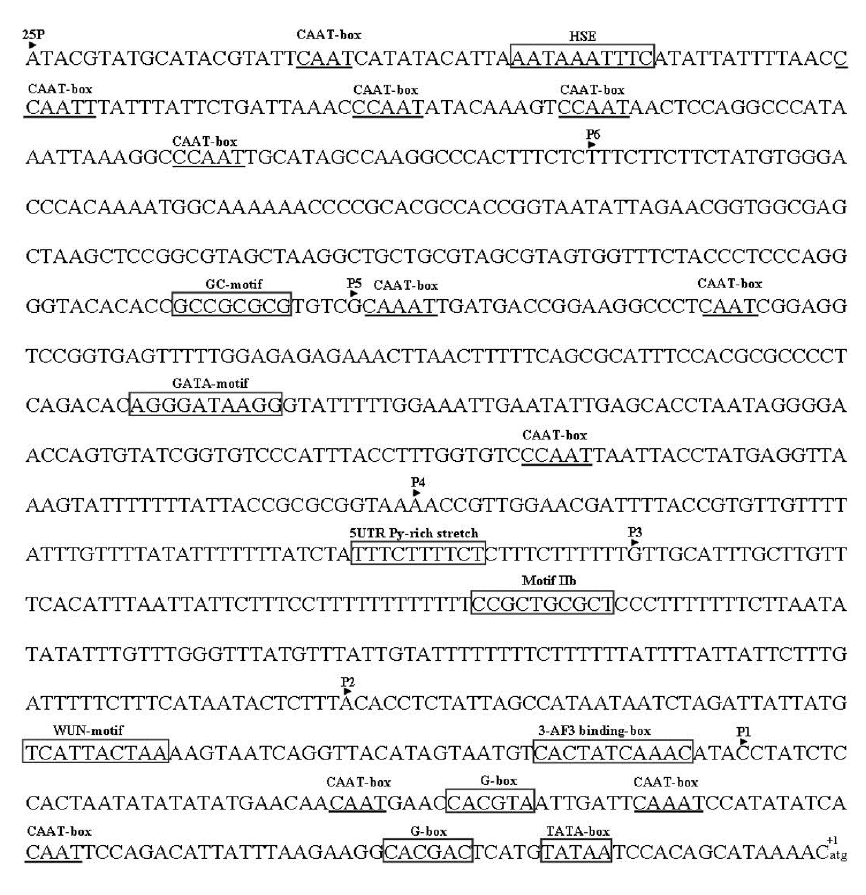
Figure 3. The nucleotide sequence encompassing the entire non-coding region (982 nt) upstream of the TYLCCNB-Y25 βC1 open reading frame. The translation start site A is labeled +1. The putative motifs are shown in frame or marked by underline.